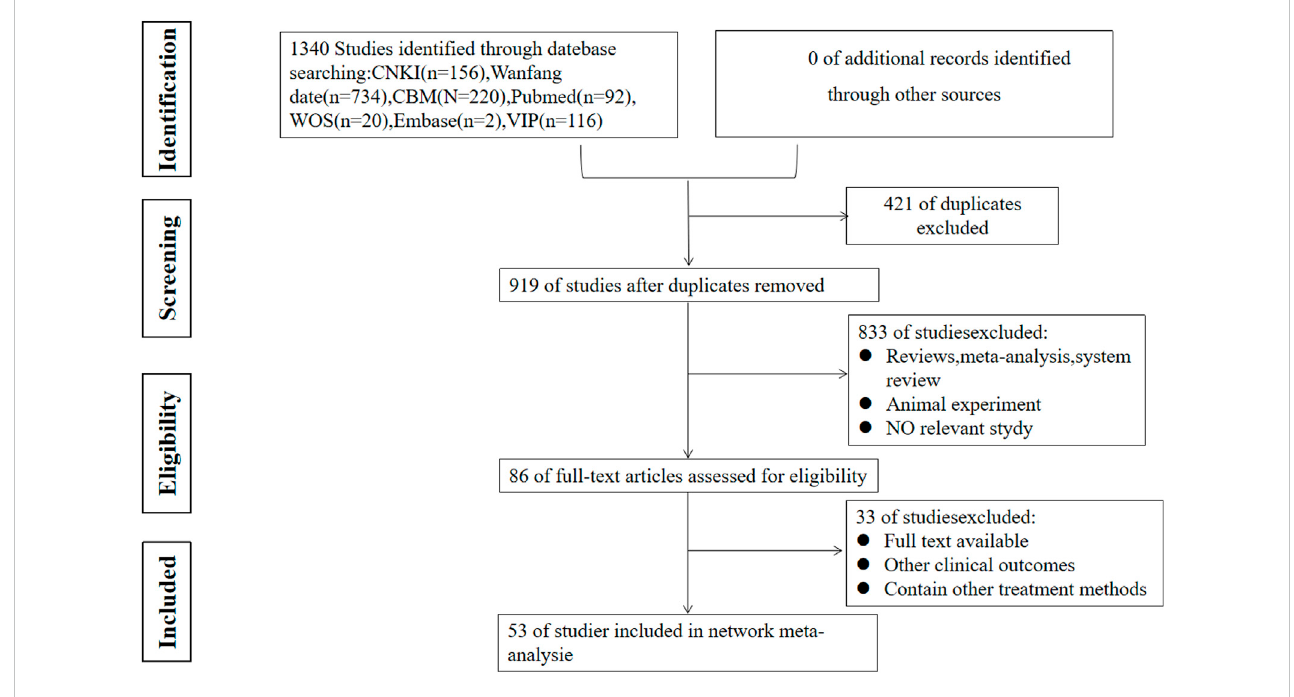
FIGURE 1 Flow chart of the study